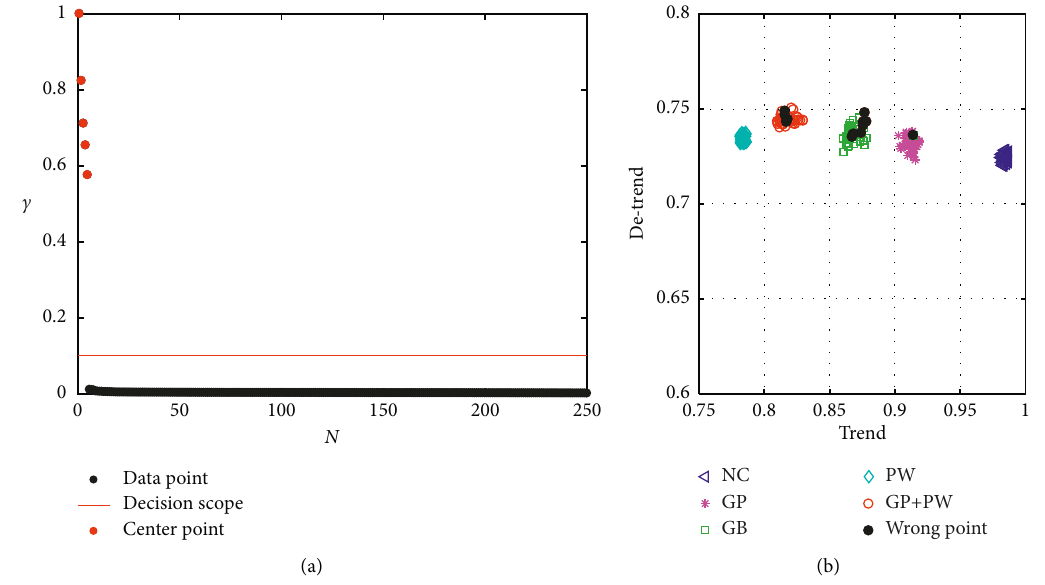
Figure 15: The clustering result of the gearbox by using the SPA-DE-DPC: (a) decision graph and (b) clustering result.